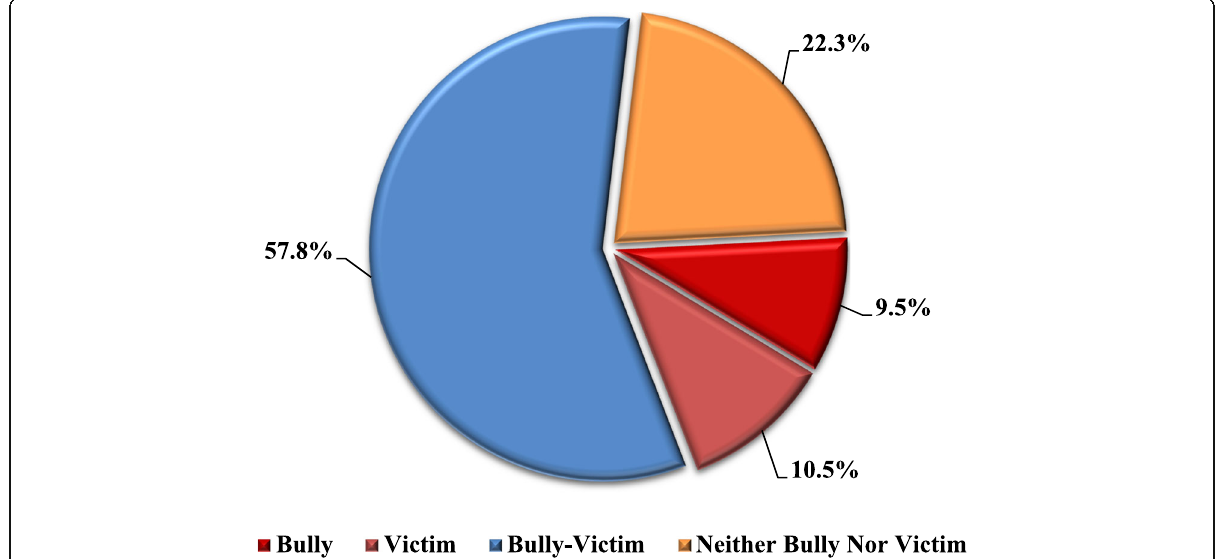
Fig. 1 Pie chart showing the percentages of bullying subgroups among adolescent school students in rural